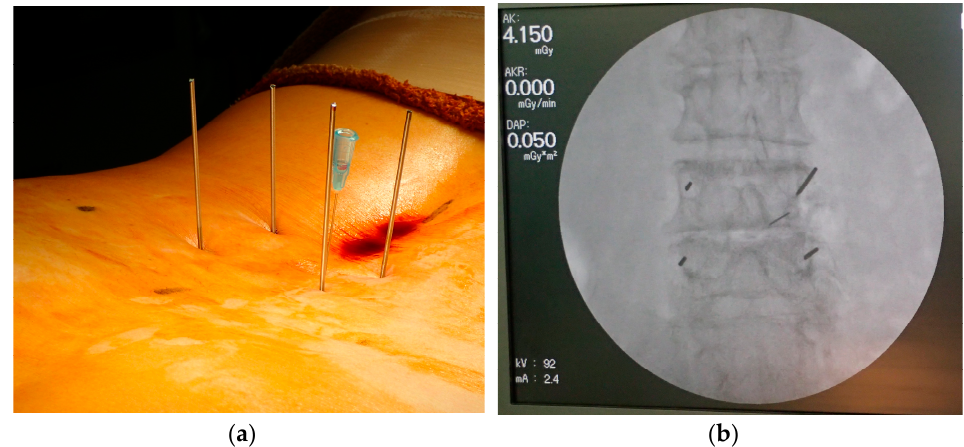
Figure 2. ( a ) Insertion of K-wires at outer edge of pedicles; ( b ) confirmation of K-wire placement under fluoroscopy.